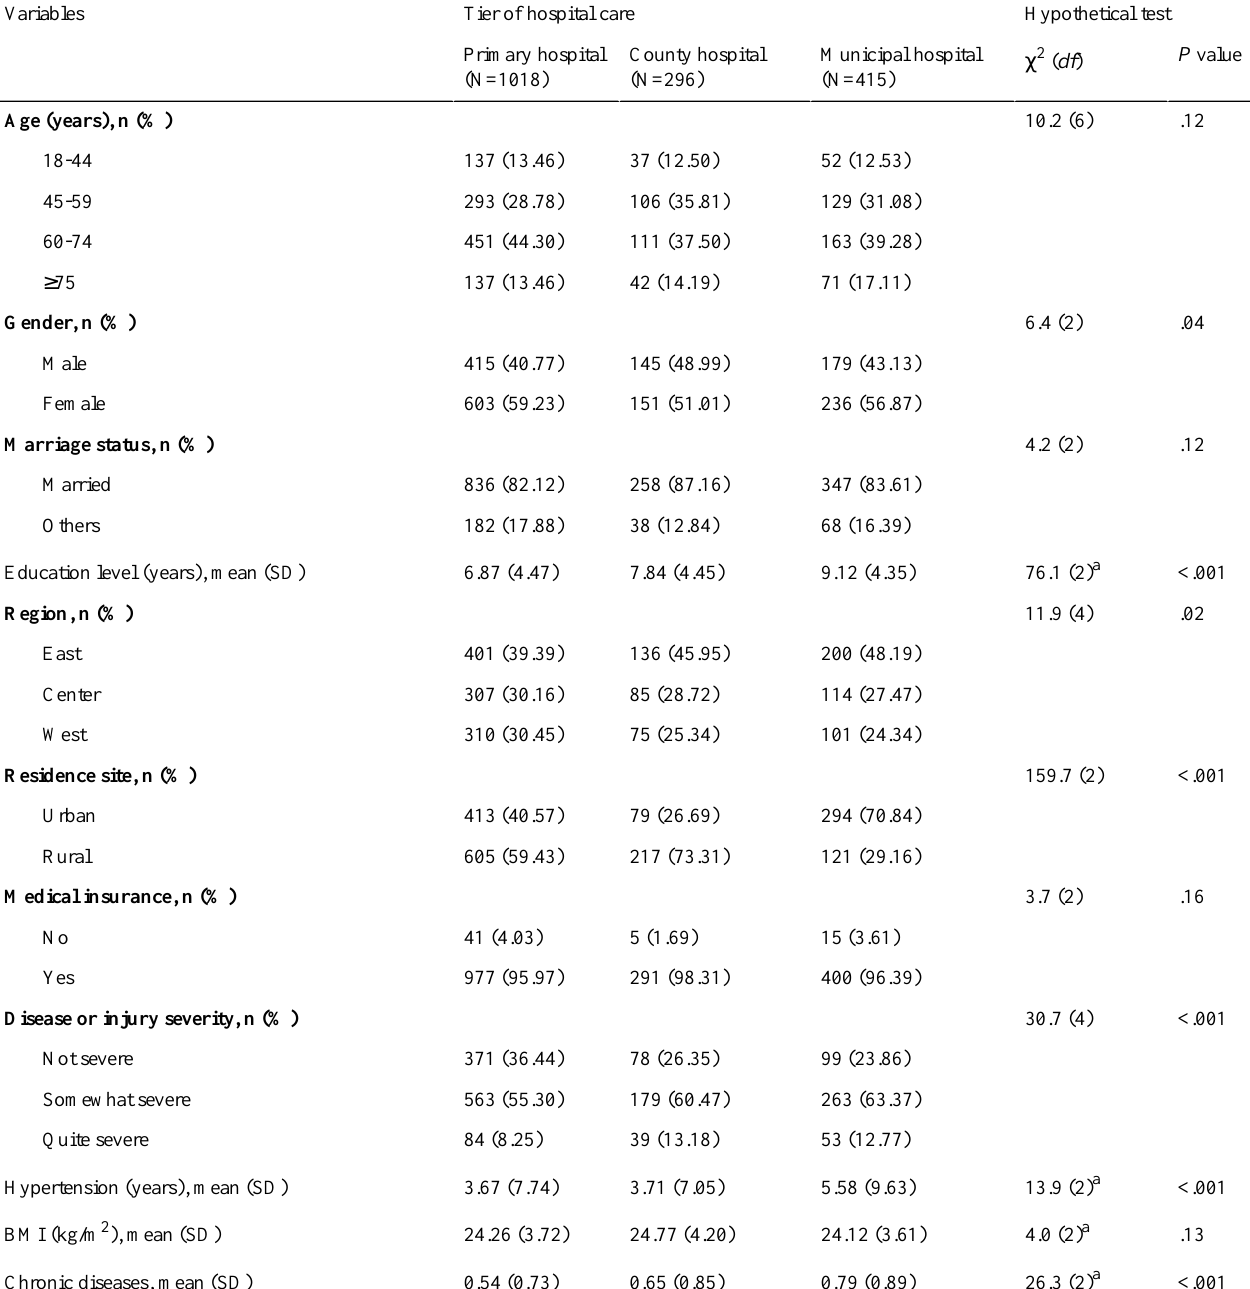
Table 3. Hospital choices for people with different characteristics in 2015 (N=1729).